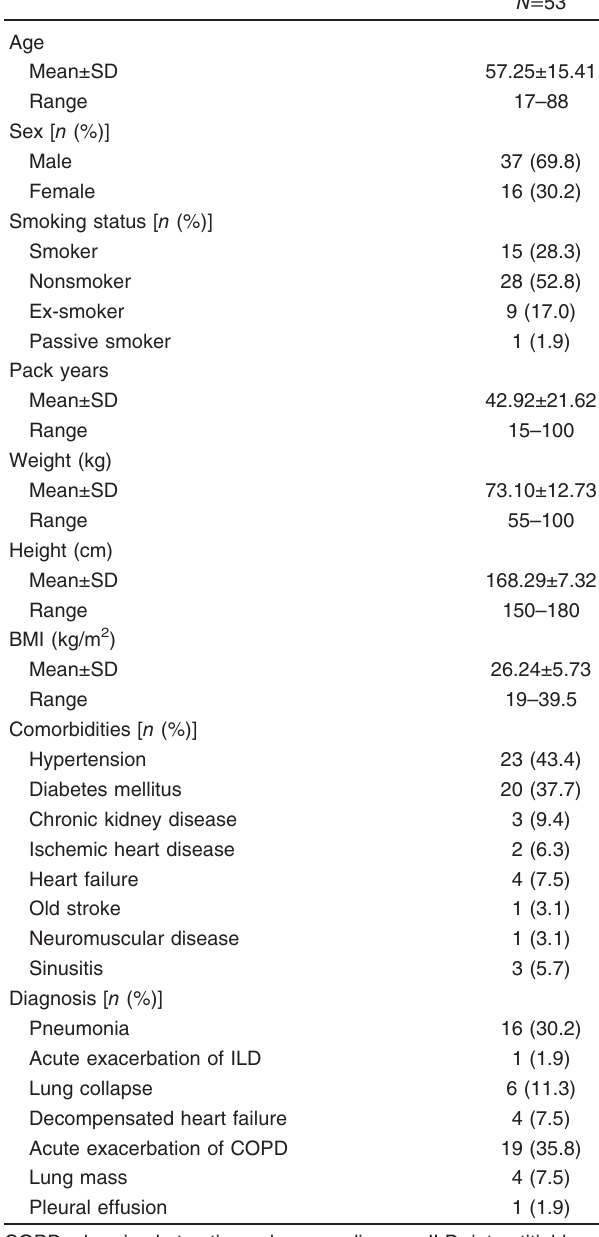
Table 1 Baseline demographic and clinical characteristics of the patients